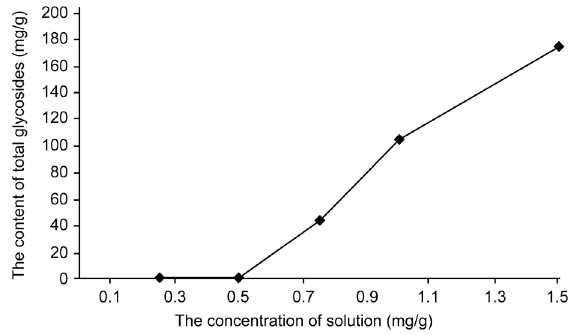
Figure 2: Adsorption capacity of resin AB-8 resin at different times.